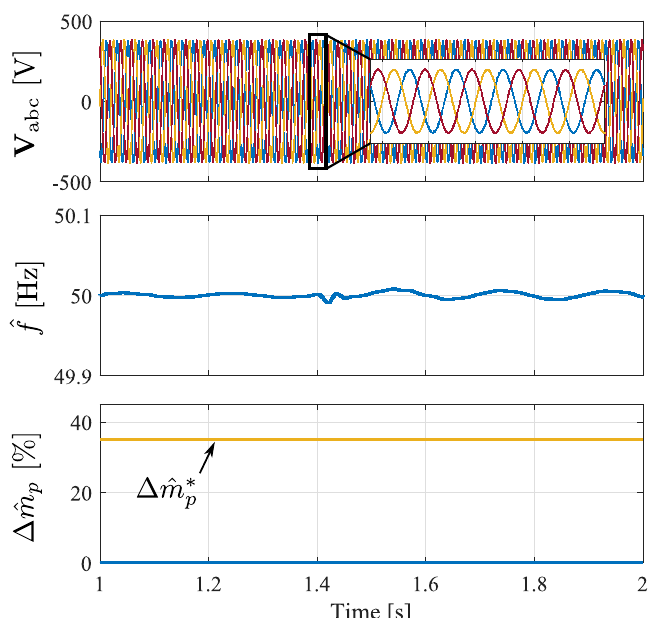
Figure 8. Case 3: Nonlinear load integration test to discard false